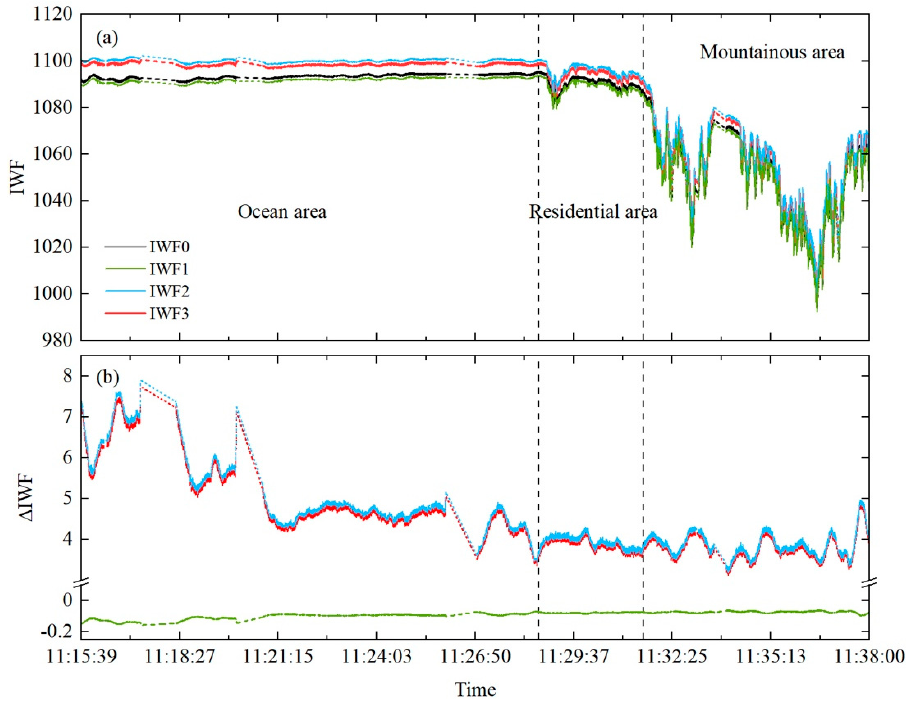
Figure 9. The comparison of the IWF results on 14 March 2019: ( a ) original and Doppler-shifted IWF results. The black line represents the original IWF results, the blue and green lines represent the IWF results with online and offline Doppler shifts, respectively, and the red line represents the IWF results with Doppler shifts of both wavelengths; ( b ) difference between the original and Doppler-shifted results. The blue and green lines represent the difference between the original, IWF results2, and IWF results1, and the red line represents the difference between the original and IWF results3.